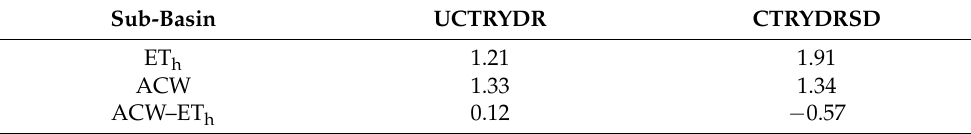
Table 6. ET h and ACW for the UCTRYDR and CTRYDRSD regions in 2014 (10 9 m 3